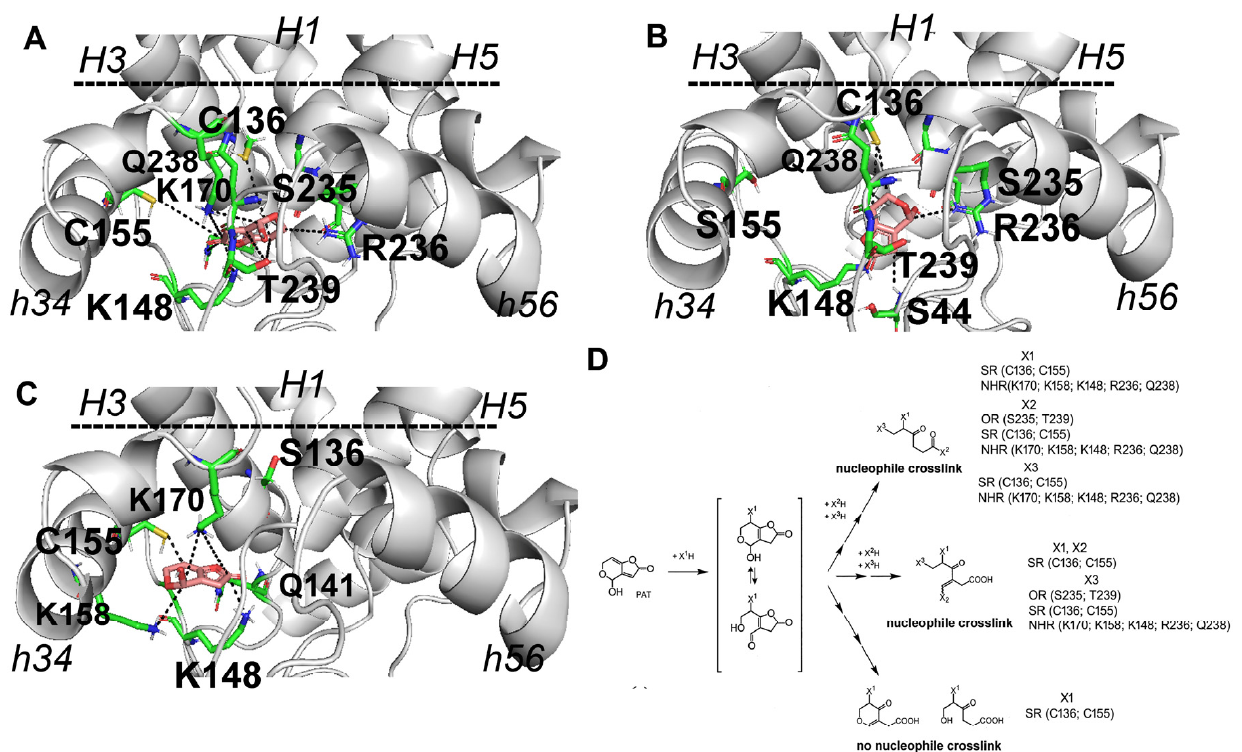
Figure 6. PAT docking analysis and possible interactions between PAT and residues of the matrix gate area, including matrix loop residues and residues of the short helices h12, h34 and h56 per- pendicular to the membrane plane. A zoomed view of the matrix gate area residues and residues of the short helices h12, h34 and h56 interacting with PAT (salmon sticks) as obtained by docking analysis on the 3D comparative model of the WT CAC (panel ( A )), CAC_C155S (panel ( B )) and CAC_C136S (panel ( C )). The 3D comparative model of the CAC protein is reported in grey cartoon representation. Protein residues between the m-gate, matrix loops, and short helices h12, h34, h56, within 4 Å from the docked PAT are reported in green sticks and labelled for comparative purposes. The black horizontal dashed bar indicates the position of the m-gate. Dashed lines indicate inter- residues distances below the 5 Å. Possible nucleophilic attacks on PAT are reported in the scheme of panel ( D ). The transmembrane odd helices H1, H3 and H5, and the short helices h34 and h56 are indicated by